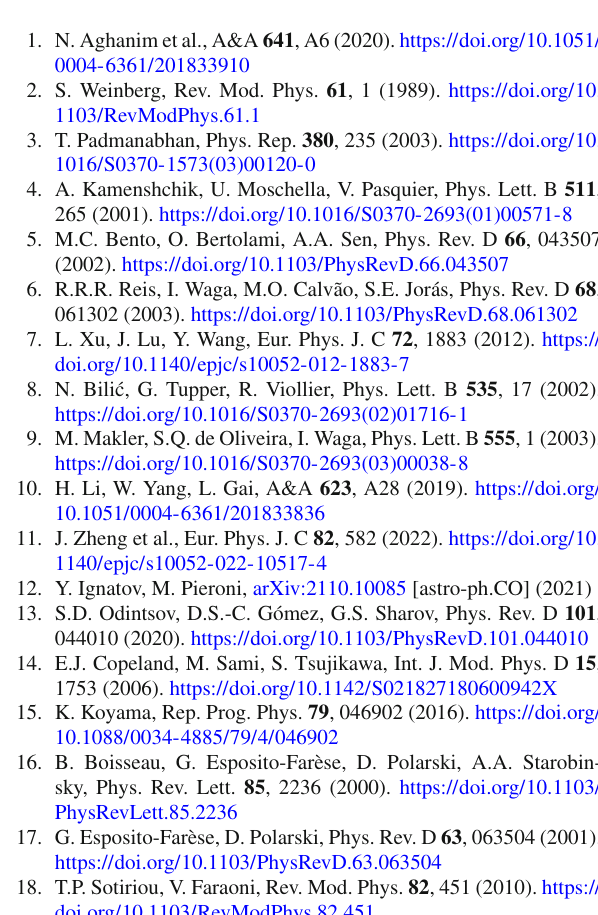
Fig. 9 Left panel: Tidal Love number plotted as a function of the com- pactness C ≡ M / R . Right panel: Dimensionless tidal deformability versus gravitational mass predicted by each model, where larger masses yield smaller deformabilities. Note also that the Love number is sub-